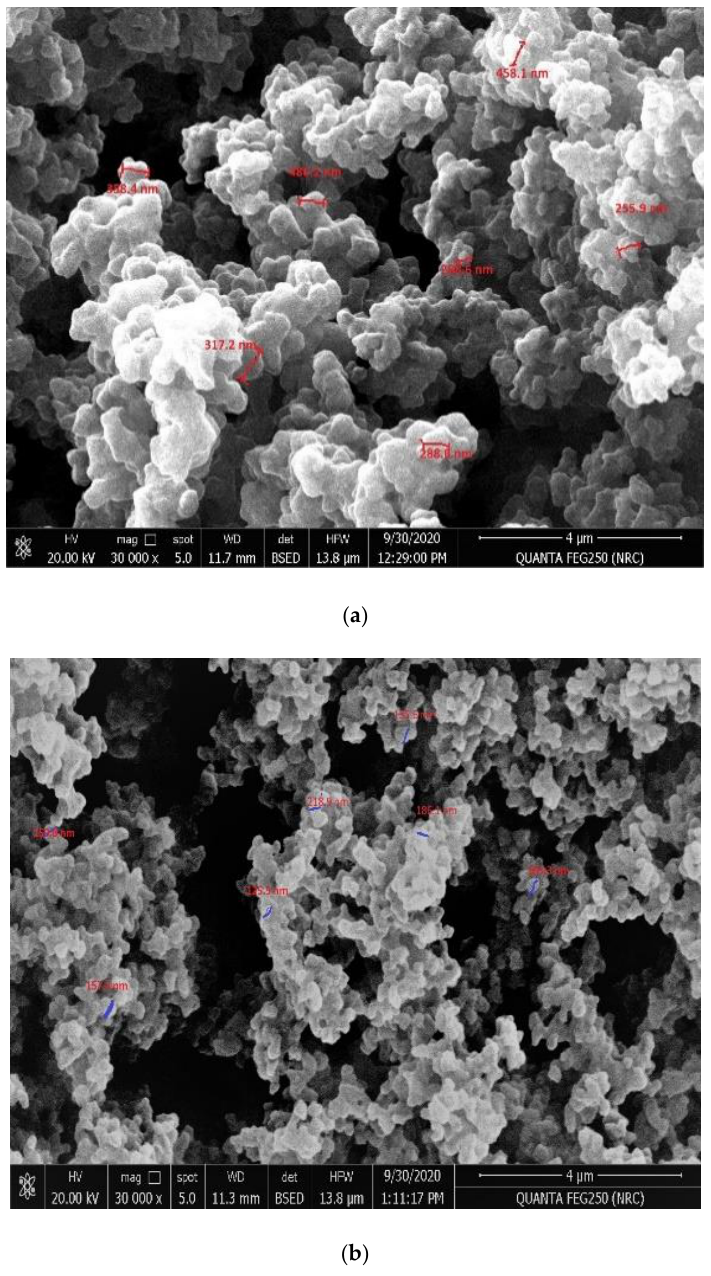
Figure 2. SEM images of ( a ) MIPs and ( b ) NIPs; [4 µm; 30,000x; 20.0 kV].